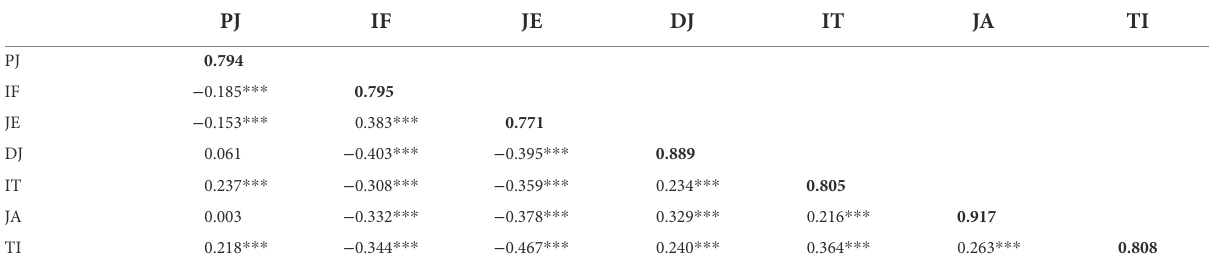
TABLE 2 Inter-factor correlation analysis.